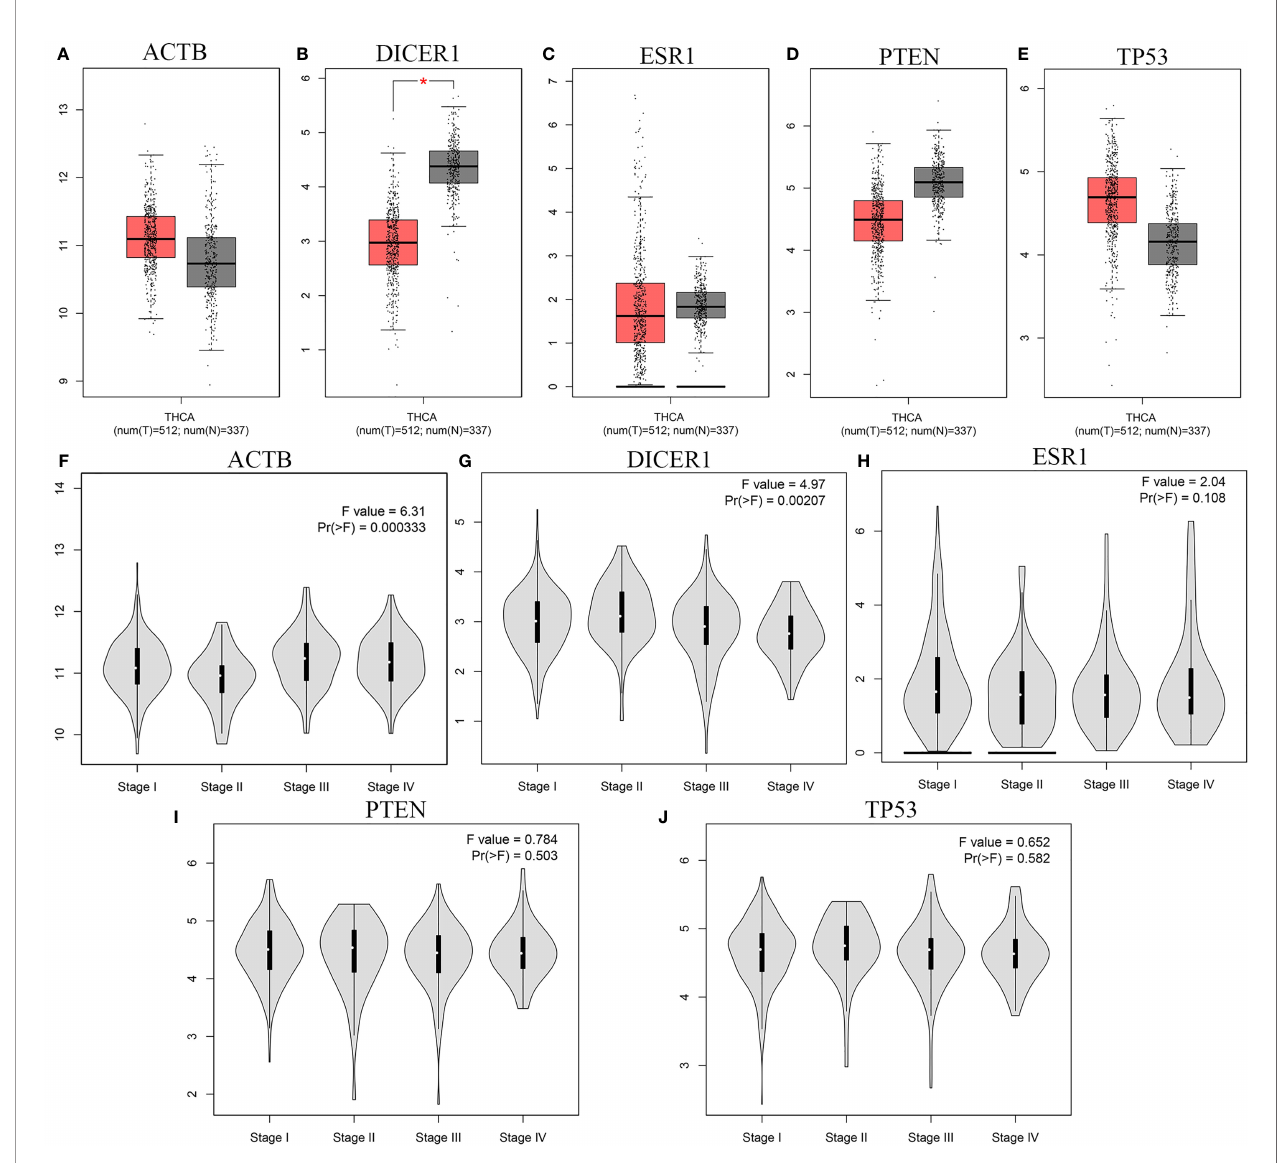
FIGURE 10 | The mRNA expression and the stage-speci fi c expression analysis results of fi ve hub genes. (A – E) The mRNA expression of the fi ve hub genes based on TCGA database with GEPIA: (A) ACTB, (B) DICER1, (C) ESR1, (D) PTEN, (E) TP53; (F – J) The stage-speci fi c expressions of hub genes in TCGA via GEPIA: (F) ACTB, (G) DICER1, (H) ESR1, (I) PTEN, (J) TP53. * means statistical signi fi